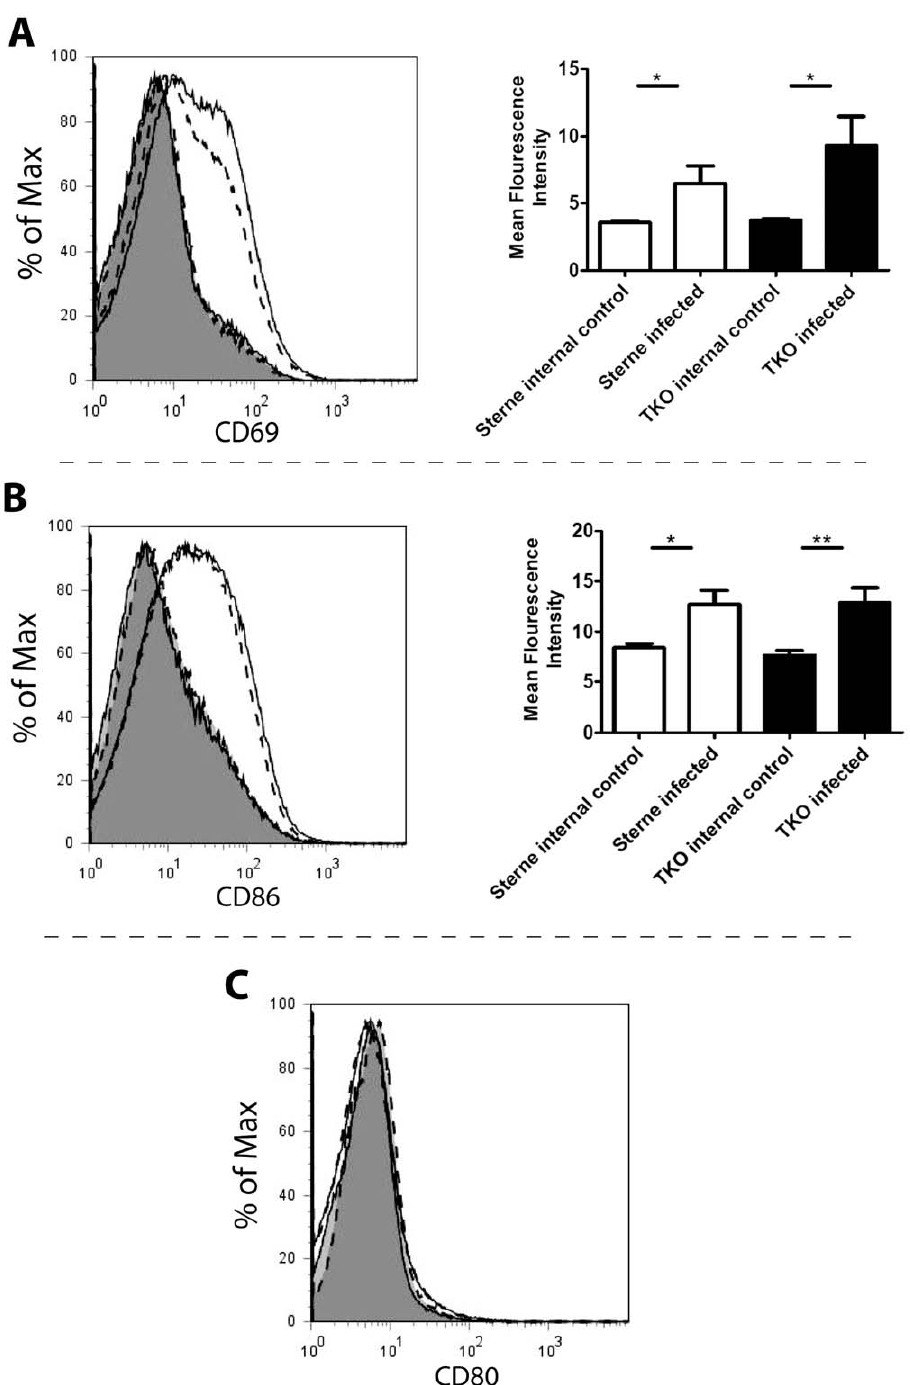
Figure 3. Presence of lethal factor in cervical draining lymph node does not alter cellular activation. Mice were infected with 1 6 10 6 Sterne strain or TKO spores subcutaneously in the left ear. At 24 hours cLN were taken from mice including: Sterne infected mice (solid line non- shaded) along with control non-infected contralateral lymph nodes from Sterne infected mice (solid line shaded), and TKO infected (dashed line non- shaded) and control non-infected contralateral lymph nodes from TKO infected mice (dashed line shaded). cLN were homogenized and cells were stained for flow cytometry. Flow plots were gated for single event live CD45 positive cells. (A) Left- a representative histogram comparing expression of CD69 in draining cLN. Right- The mean fluorescence intensity of lymph nodes draining either Sterne (*, p=0.0464) or TKO (*, p=0.0256) infections from seven mice was significantly higher than contralateral control lymph nodes as determined using Student’s T test. (B) Left- a representative histogram comparing expression of CD86 in draining cLN. Right- The mean fluorescence intensity of lymph nodes draining either Sterne (*, p=0.0119) or TKO (**, p=0.0063) infections from seven mice was significantly higher than contralateral control lymph nodes as determined using Student’s T test. (C) A representative comparison of CD80 expression in draining cLN. The mean fluorescence intensity of lymph nodes draining either Sterne or TKO infections from seven mice was not significantly higher than lymph nodes that were not.